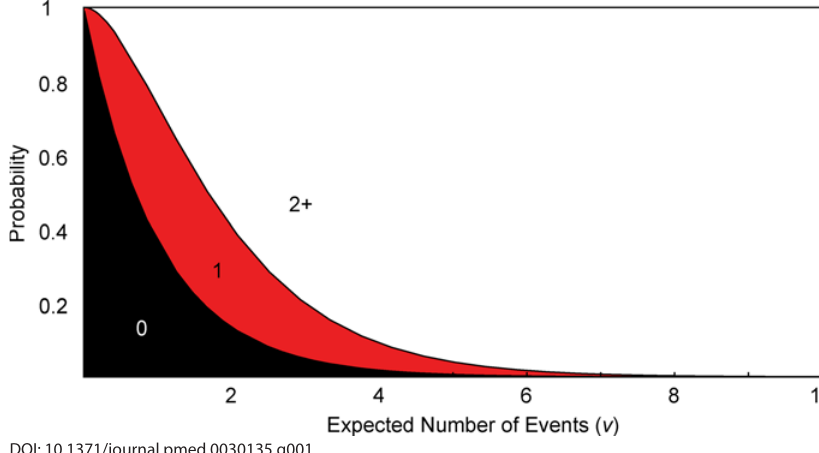
DOI: 10.1371/journal.pmed.0030135.g001 Figure 1. Probabilities of Zero, One, or Two or More Events (Introductions of a Pandemic- Capable Strain) When the Expected Number of Events Ranges from Zero to Ten, under a Constant Hazard (Poisson Distribution) Note that if the expected number of events (v) is more than 1.26, then it is more likely that two or more events will occur than that exactly one event will occur.